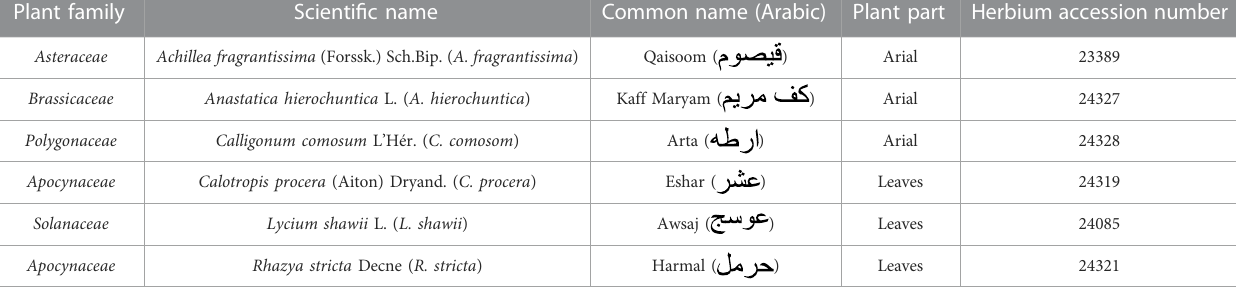
TABLE 1 List of the medicinal